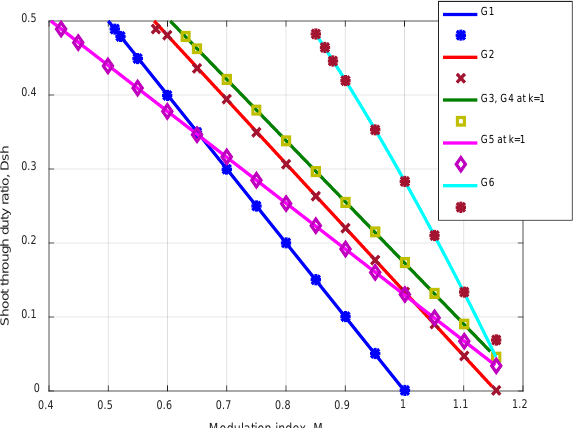
Figure 18. Modulation index versus ST duty ratio, solid lines: theoretical results, marks: simulation results.